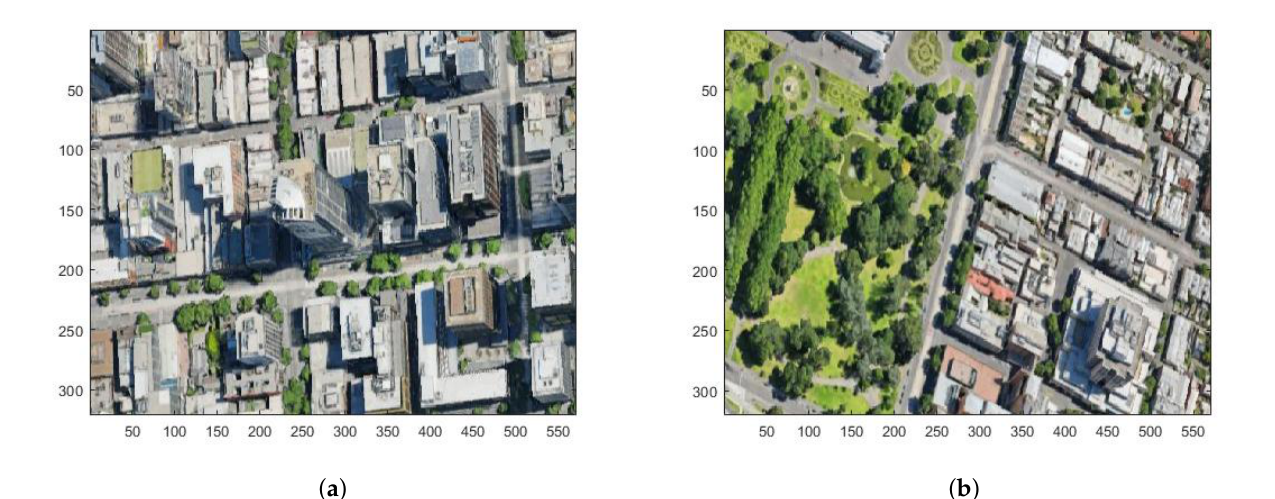
Figure 8. ( a ) UAV aerial image taken at the UAV starting location (red square). ( b ) Georeferenced image taken at the location of the green circle in Figure